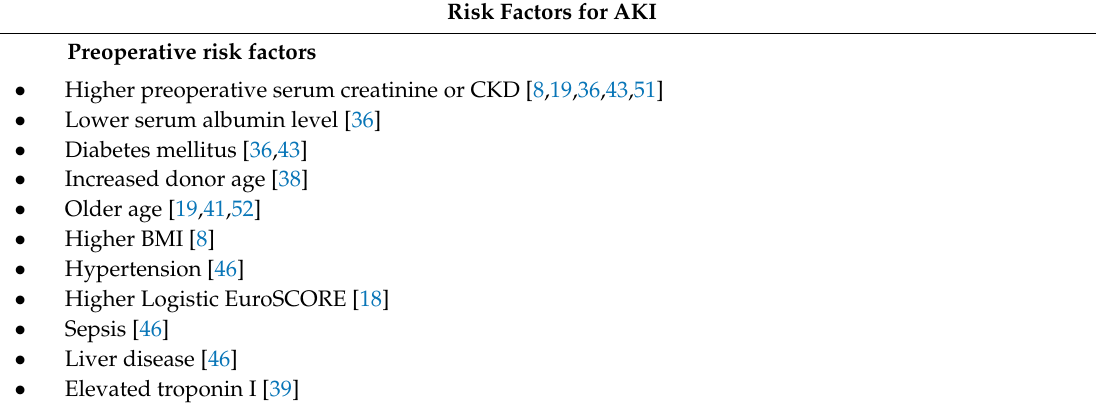
Table 3. Reported Risk Factors for AKI among Patients Undergoing Cardiac